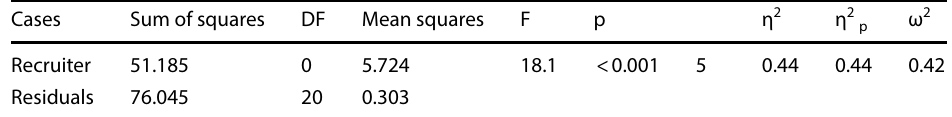
Cases Sum of squares DF Mean